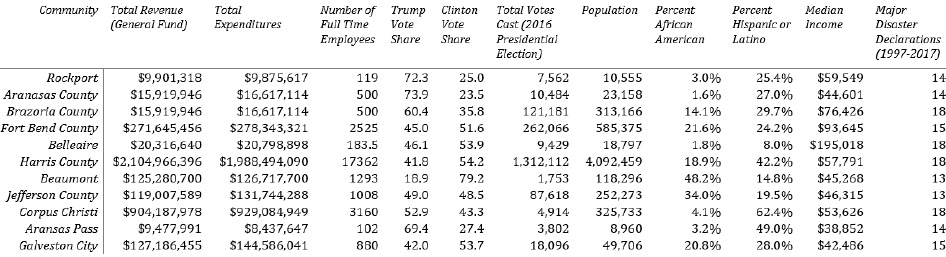
Table 1: Community Characteristics Communities in the Study Area